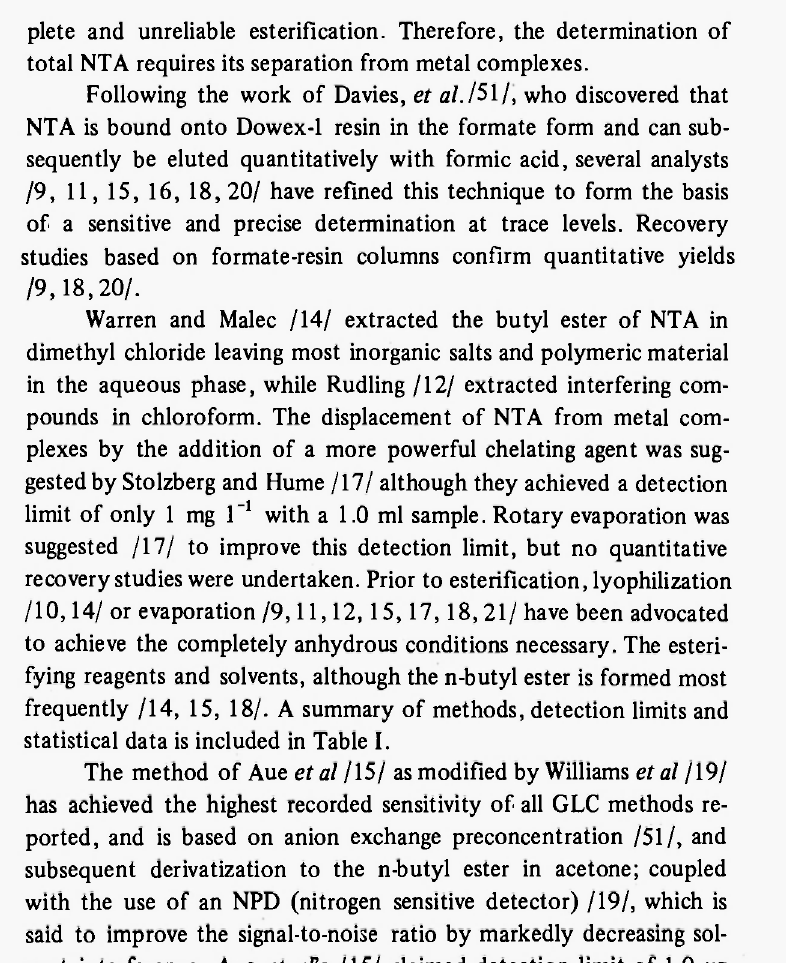
(Table 1) was improved to 0.2 /ig Γ 1 by the use of an NPD (ni- trogen and phosphorus detector) /19/, although a recent survey of drinking water by Malaiyandi et al /20/ suggests that such sensitivity may only be achieved by purification of the ion exchange resin with redistilled formic acid, until the washings (after derivatisation) are free of interfering nitrogen-containing compounds. Fortification studies carried out by Malaiyandi et al /20/ on potable waters indicate